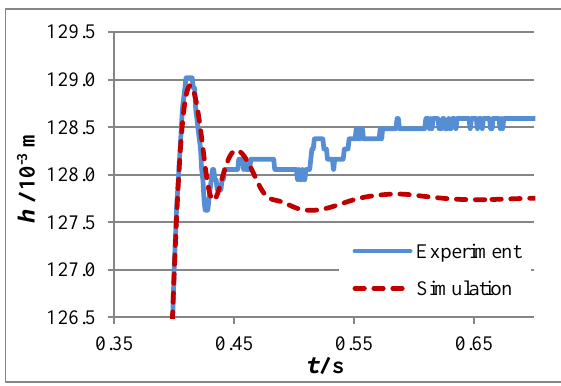
Fig. 9. Time dependencies of measured and simulated piston positions .